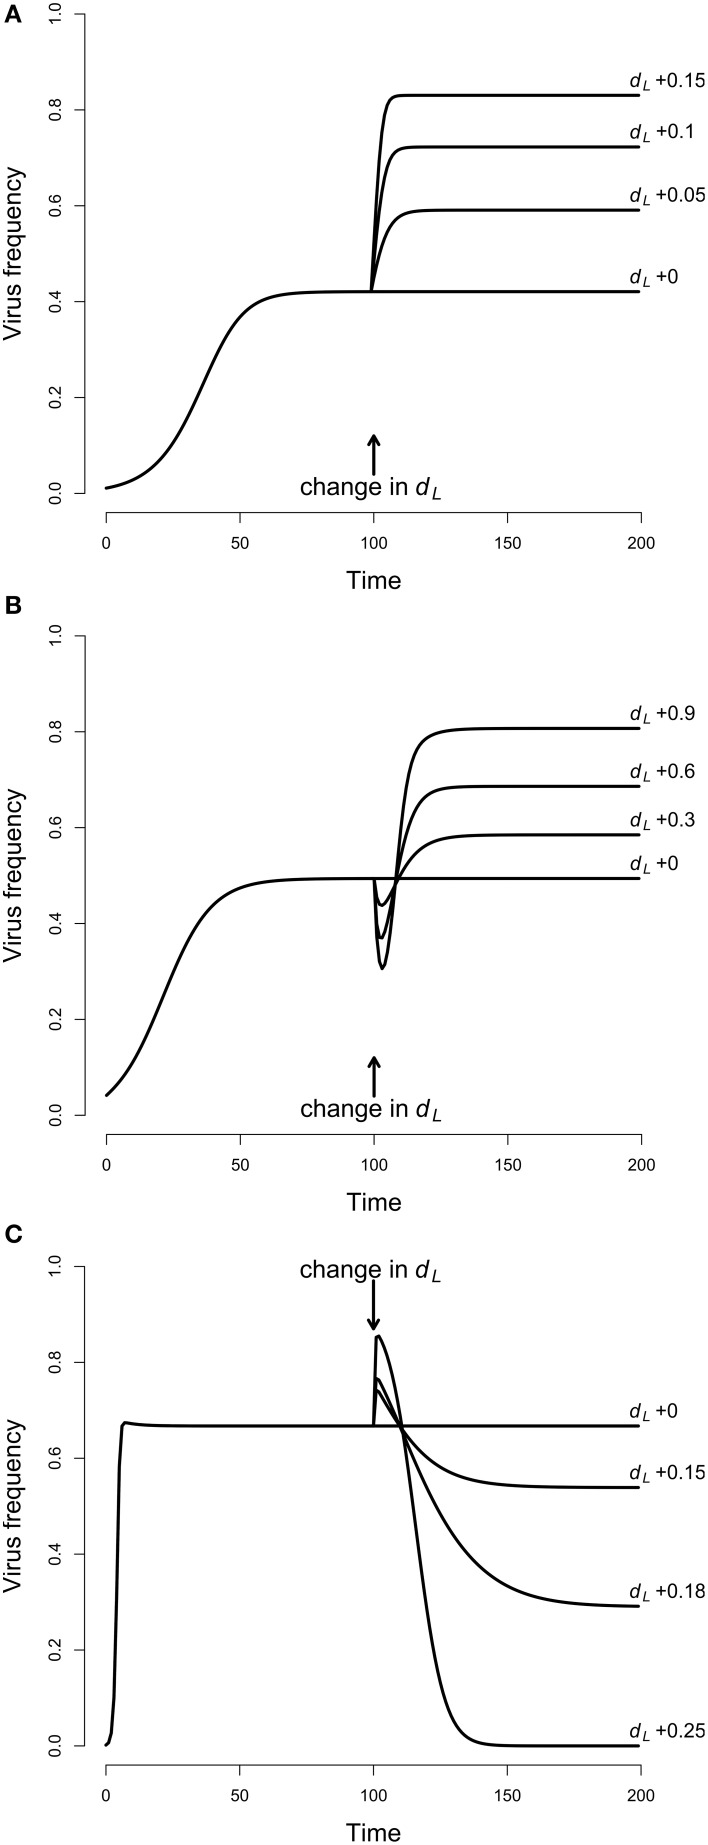
Temporal dynamics of virus frequencies. The virus was introduced to the host population with low frequency of 1% and then allowed to reach equilibrium. At generation 100 larval mortality dL was increased and changes in virus frequencies were observed. (A) Adult competition model (ACM). The larval mortality dL = 0.8 was increased by 0.05, 0.1, and 0.15. This resulted in increased virus frequencies, and highest equilibrium values were reached for highest larval mortality. Parameters: dA = 0.1, ε = 1, s = 0.2, tV = 0.95. (B) Larval competition model (LCM) with overcompensation. The larval mortality, starting with dL = 0 was increased by 0.3, 0.6, and 0.9. The virus frequencies declined first, and increased afterwards up to high equilibrium values. Strongest effects occurred for the largest dL. Parameters: α = 0.15, β = 0.6, dA = 0.1, ε = 15, s = 0.1, tV = 0.95, K = 100. (C) LCM with undercompensation. The larval mortality dL = 0.7 was increased by 0.15, 0.18, and 0.25. This resulted in virus dynamics opposite to (B), i.e., there is first an increase and then a decrease of the virus frequencies. Lowest equilibrium frequencies occurred for largest dL. Parameters: α = 0.1, β = 0.4, dA = 0.1, ε = 4, s = 0.1, tV = 0.95, K = 100.